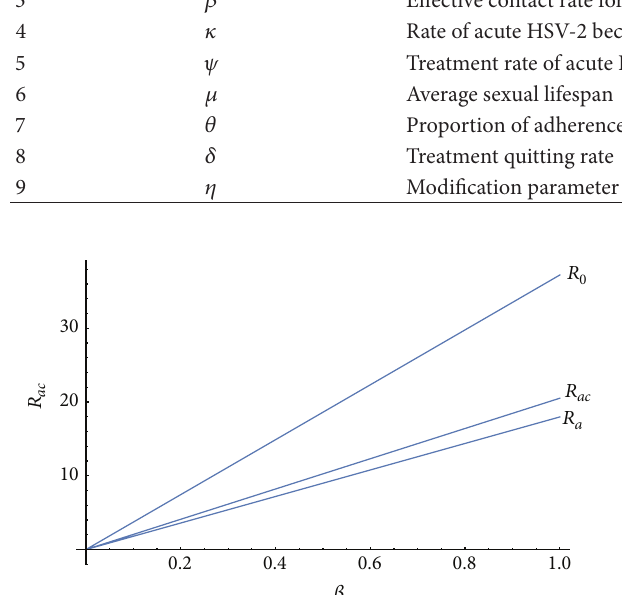
Figure 1: Effect of varying the effective contact rate 𝛽 on the reproduction